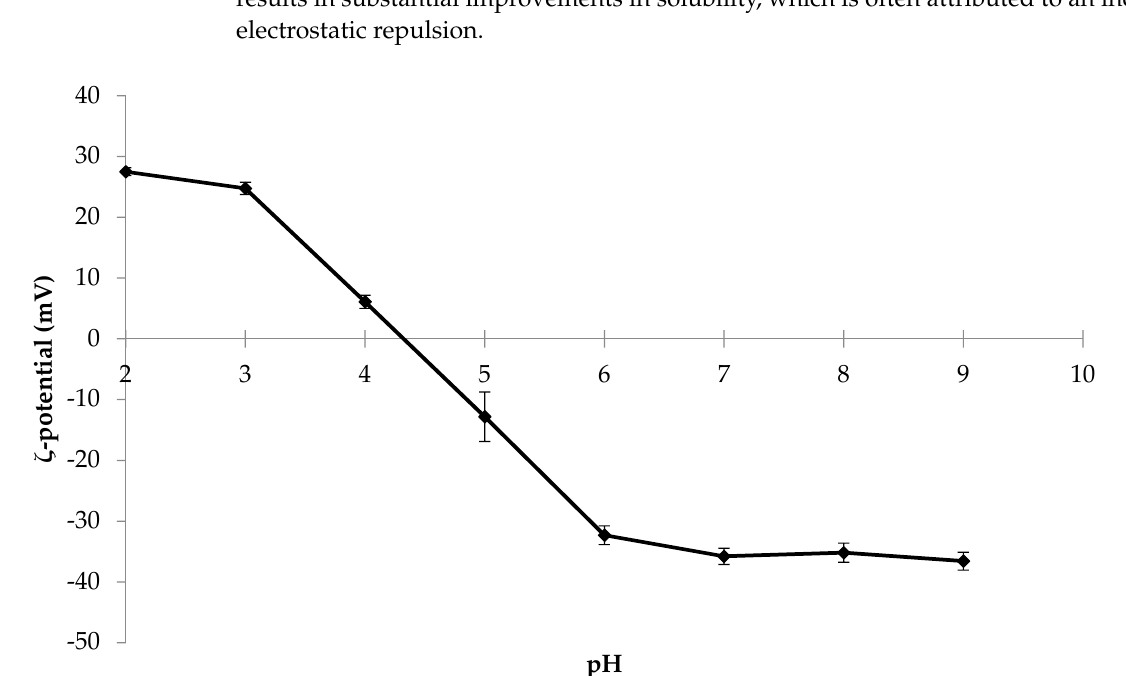
Figure 1. Zeta potential as a function of pH for soy protein isolate dispersions. The effect of pH on the colour profile of SPI dispersions is shown in Table 1. Increasing the pH from pH 6.9 (control pH) to pH 9.0 resulted in decreases in the values for L * (63.8 to 43.5), a * ( − 2.13 to − 3.19) and b * (7.12 to 1.63) parameters, which is indicative of a decrease in whiteness and an increase in yellow and blue hue. The changes in the L * value were partly reversible, as shown in Table 1, once the pH was adjusted back to pH 6.9; however, a * and b* values decreased further. This seems to be in general agreement with the study of Jiang et al. (2010), who found that adjusting the pH of SPI to pH 12, equilibrating for 1 h, before re-adjusting back to pH 7.0 resulted in a lower turbidity than SPI dispersions prepared at pH 7.0 [21]. However, decreasing the pH from 6.9 to 2.0 did not result in a significant change in L * (63.8 to 62.6) or a * values (2.13 to − 2.62) with only a minor decrease in the b * values (7.12 to 5.57). This is indicative of the SPI dispersion changing to a slightly darker, green and blue dispersion. After readjustment of pH back to pH 6.9, the L * value reduced further to 57.91, with a * and b * values returning to their original values. Again, this seems to align with data shown by Jiang et al. (2010) when adjusting the pH of SPI to pH 1.5 before re-neutralising to pH 7, resulting in very little change in turbidity between it and SPI dispersions at pH 7.0, when measured at 20 ◦ C [21]. It is well understood that adjusting the pH of SPI dispersions to extremely acidic or alkaline environments causes a significant change in the tertiary and quaternary structure of both β -conglycinin and glycinin, resulting in protein dissociation and the formation of subunits, which will ultimately affect colour properties. Table 1 also shows the effect of pH on the colour profile of heat-treated SPI disper- sions. Comparing the colour of dispersions heat-treated at pH 6.9 to the dispersion at pH